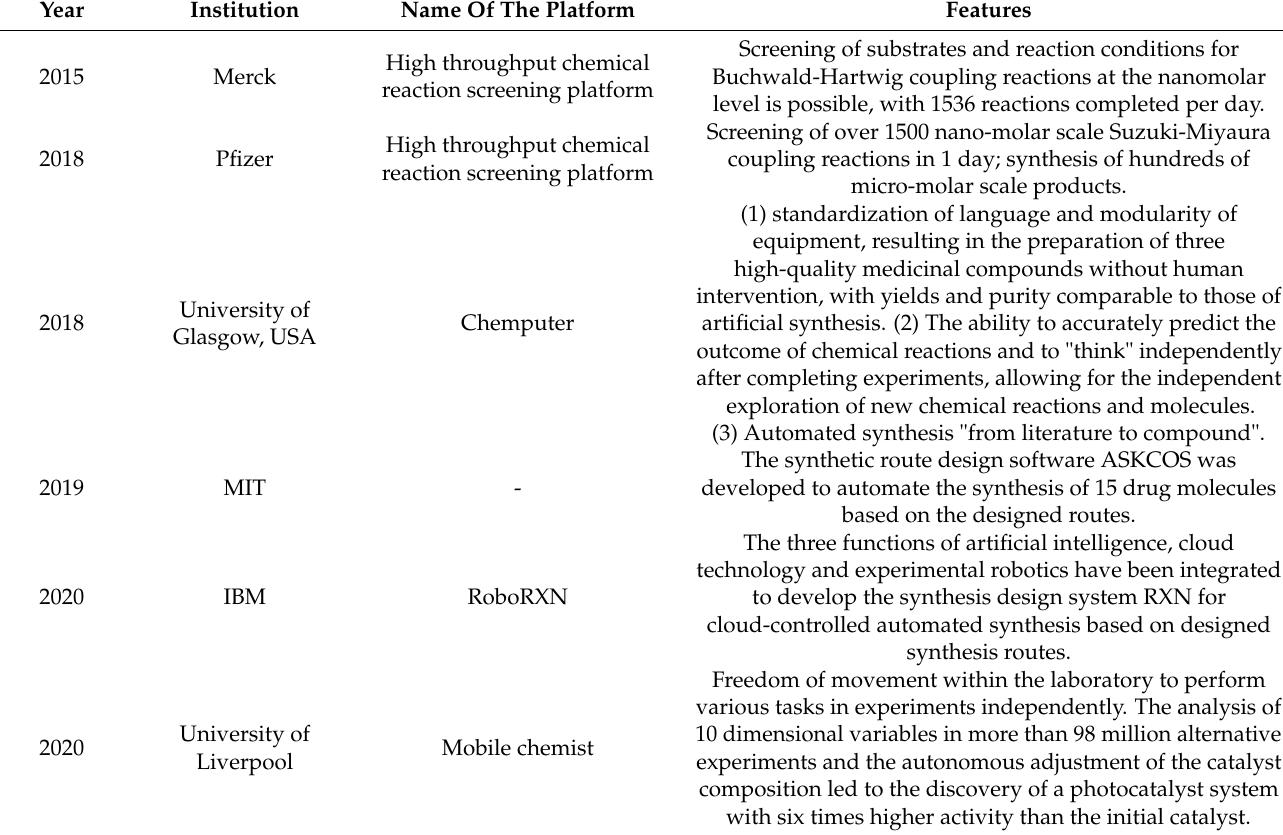
Table 1. Summary of representative work in the field of automated and intelligent